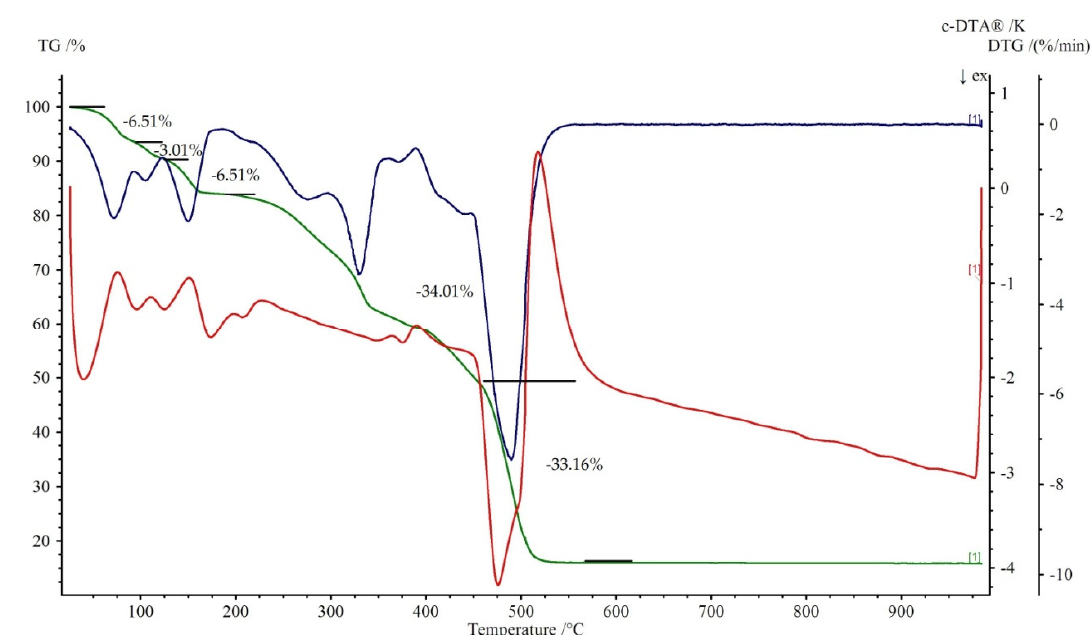
Figure 7. Thermoanalytical curves of 1 . Thermogravimetric (TG) is in green with percentage weight losses, DTG is in blue while DTA is in red.